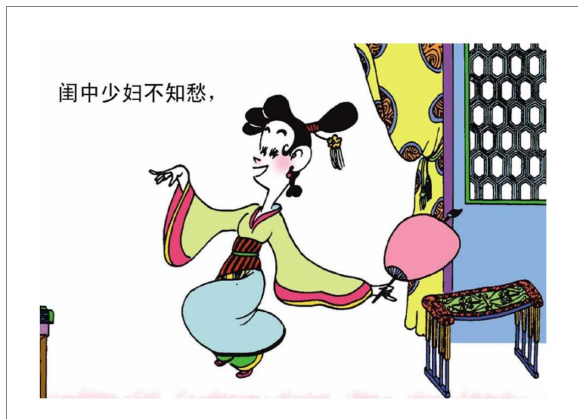
FIGURE 10 The second panel on Cai (2014, p. 33). Images reproduced with permission from Shang Dong People